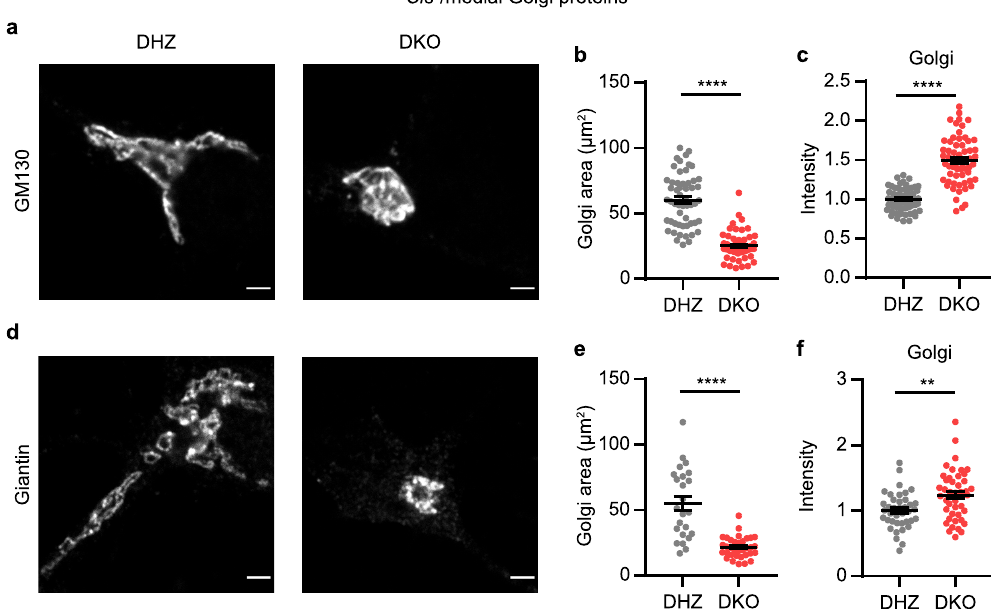
Figure 1. Staining intensity of cis-/ medial Golgi proteins is increased in Vti1a/b deficient neurons. ( a ) Representative examples of neurons immunostained for GM130. ( b ) Decreased Golgi area based on GM130 staining in Vti1a/b DKO neurons (n = 66) compared to DHZ controls (n = 64). Mann Whitney test: ****p < 0.0001. ( c ) GM130 normalized staining intensity in the Golgi is increased (DHZ: n = 65, DKO: n = 61). t -test: ****p < 0.0001. ( d ) Representative examples of neurons immunostained for giantin. ( e ) Decreased Golgi area based on giantin staining in Vti1a/b DKO neurons (DHZ: n = 29; DKO: n = 39). t -test: ****p < 0.0001. ( f ) Giantin normalized staining intensity in the Golgi is increased (DHZ: n = 39; DKO: n = 44). t -test: **p = 0.0017. Bars show mean ± SEM. Detailed statistics are shown in Supplementary Table 1. Scale bar is 2